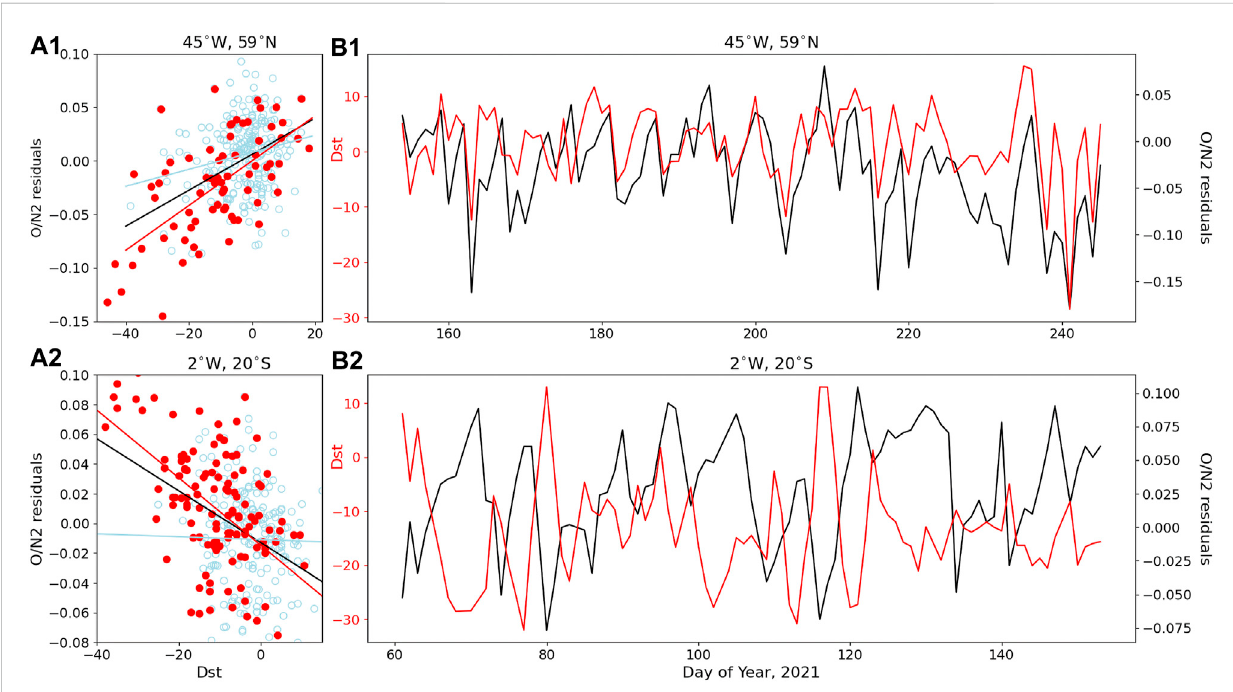
FIGURE 4 (A1,A2) O/N 2 residuals versus Dst (scattered points) and their corresponding linear fi ts (straight lines) at (45 ° W, 59 ° N), and (2 ° W, 20 ° S). Light blue and redcolorsrepresentquietandstorm-times.Thesolidblacklineineachpanelis fi ttedtoalldatapoints. (B1,B2) O/N 2 residuals(black lines)anddailymean Dst (red lines) as a function of day of year at (45 ° W, 59 ° N), and (2 ° W, 20 °